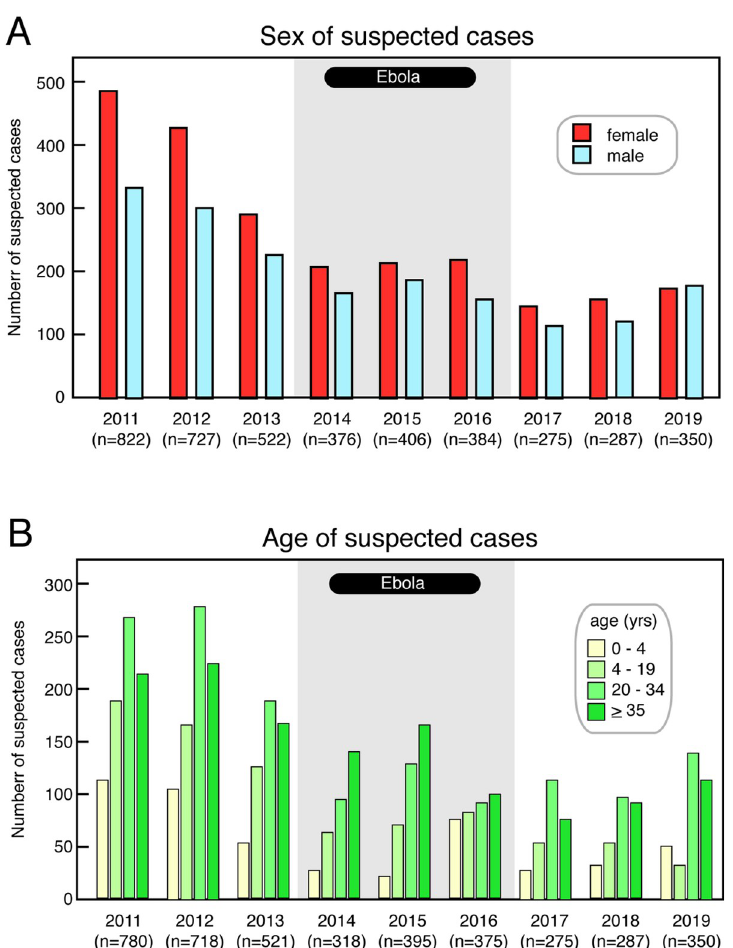
Fig 2. Sex and age of subjects with suspected Lassa fever presenting to the Kenema Government Hospital. Panel A: Numbers of female and male subjects presenting with suspected Lassa fever from 2011–19. Panel B: Numbers of subjects presenting with suspected Lassa fever from 2011–19 by age category. Grey shading indicates the years 2014–16 during the West African Ebola